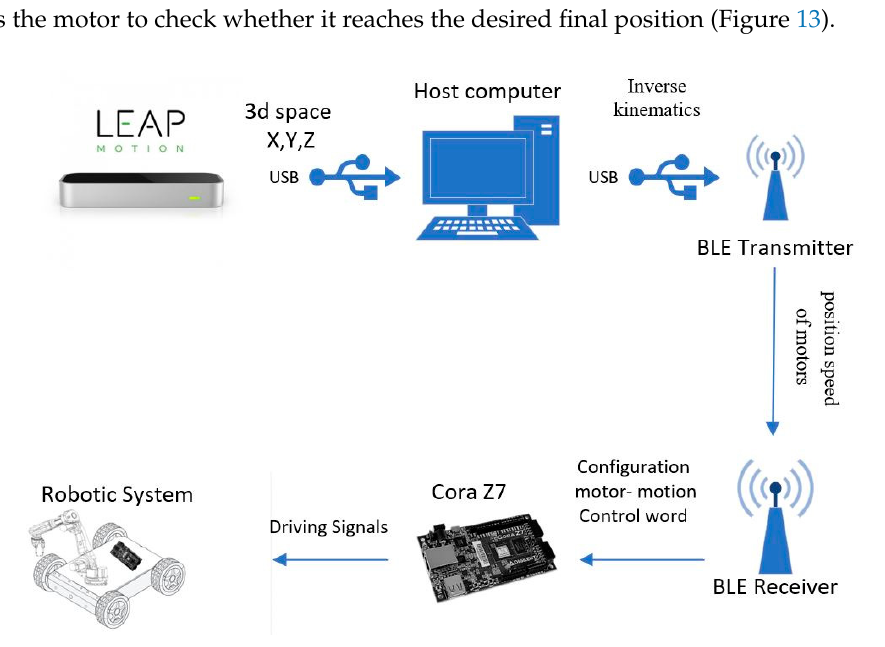
Figure 12. Algorithm Steps of main program loop.